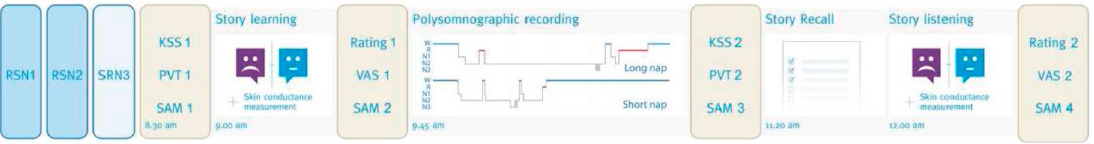
Figure 1. Time course for one session. RSN = Regular Sleep Night (8 h); SRN = Sleep Restriction Night (6 h); KSS = Karolinska Sleepiness Scale; PVT = Psychomotor Vigilance Task; SAM = Self-Assessment Manikin; Rating = rating of the 6 emotions; VAS = Visual Analogous Scale.